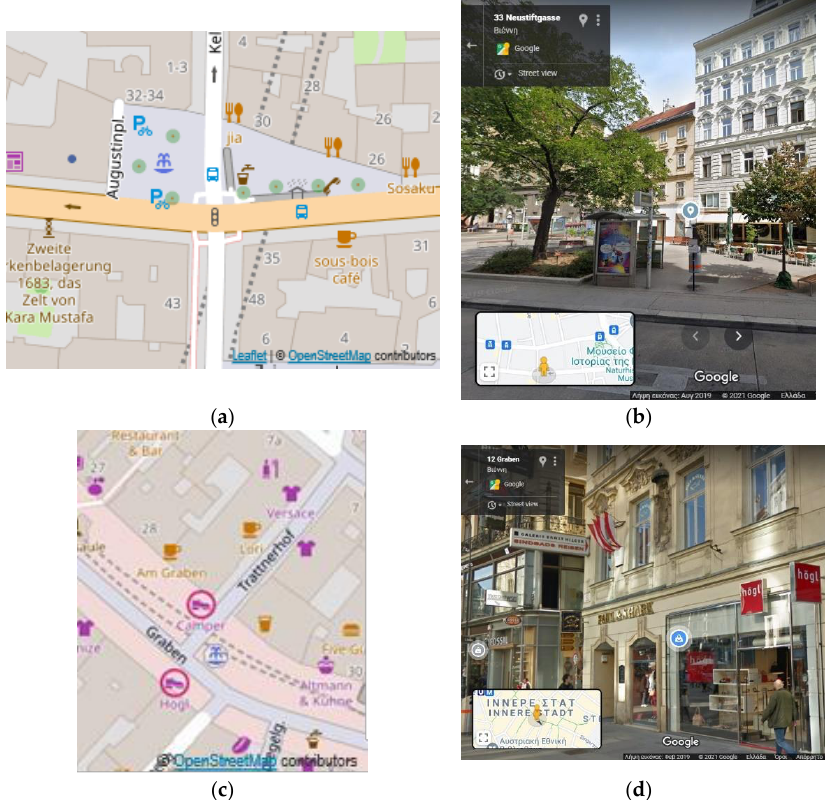
Figure 1. Consistency errors in OSM in Vienna. A bus stop appears inside a road ( a ), whereas, in reality, it is on the pedestrian street (https://goo.gl/maps/DjJtvmhuHwgR3Lvy6 accessed on 10 May 2021) ( b ). A shoe shop appears outside of the building ( c ), whereas, in reality, it is inside (https://goo.gl/maps/fbnULEMyZ4MJAgbq5 accessed on 10 May 2021) ( d ).